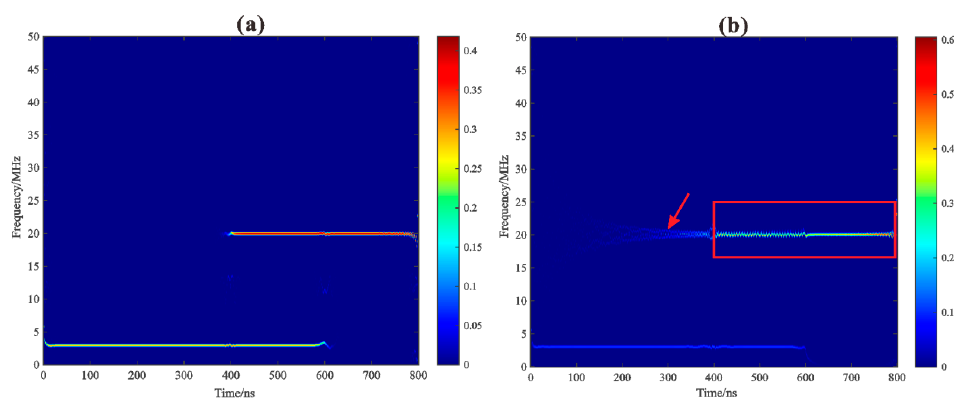
Figure 5. Time − frequency representation of channel − 1 based on ( a ) the MVMD and ( b ) the VMD, respectively.